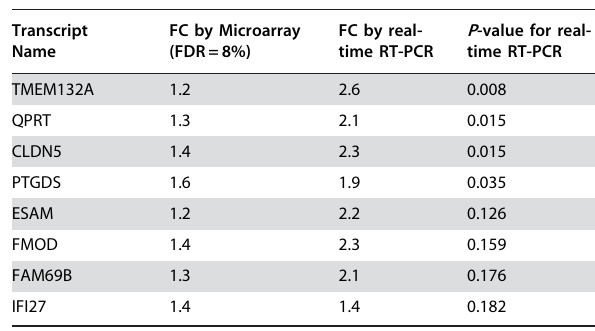
Table 2. Validation of 8 predictors by real-time RT- PCR